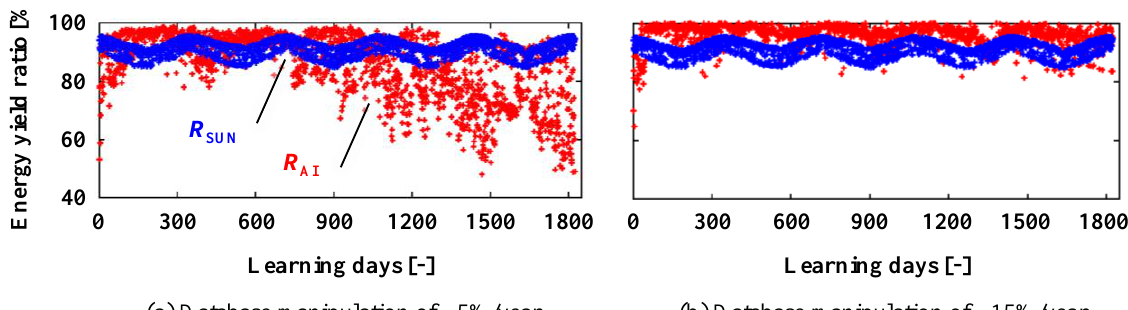
Figure 14. Effect of PF max value manipulation in the database for the same simulation as in Figure 13.